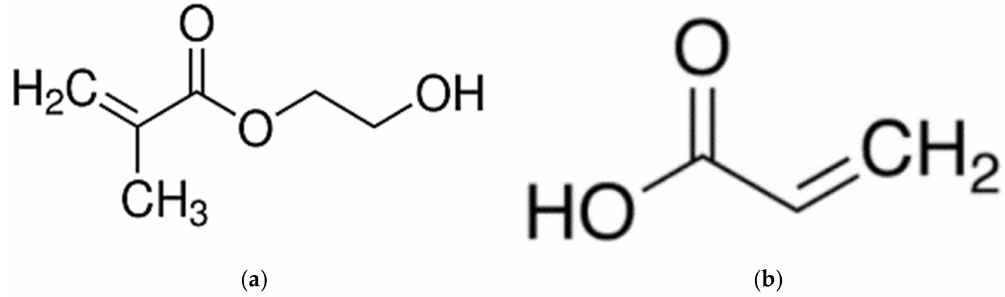
Figure 1. Chemical structure of ( a ) 2-hydroxyethyl methacrylate (HEMA) (MW: 130.14 g / mol) and ( b ) acrylic acid (AA) (MW: 72.06 g /